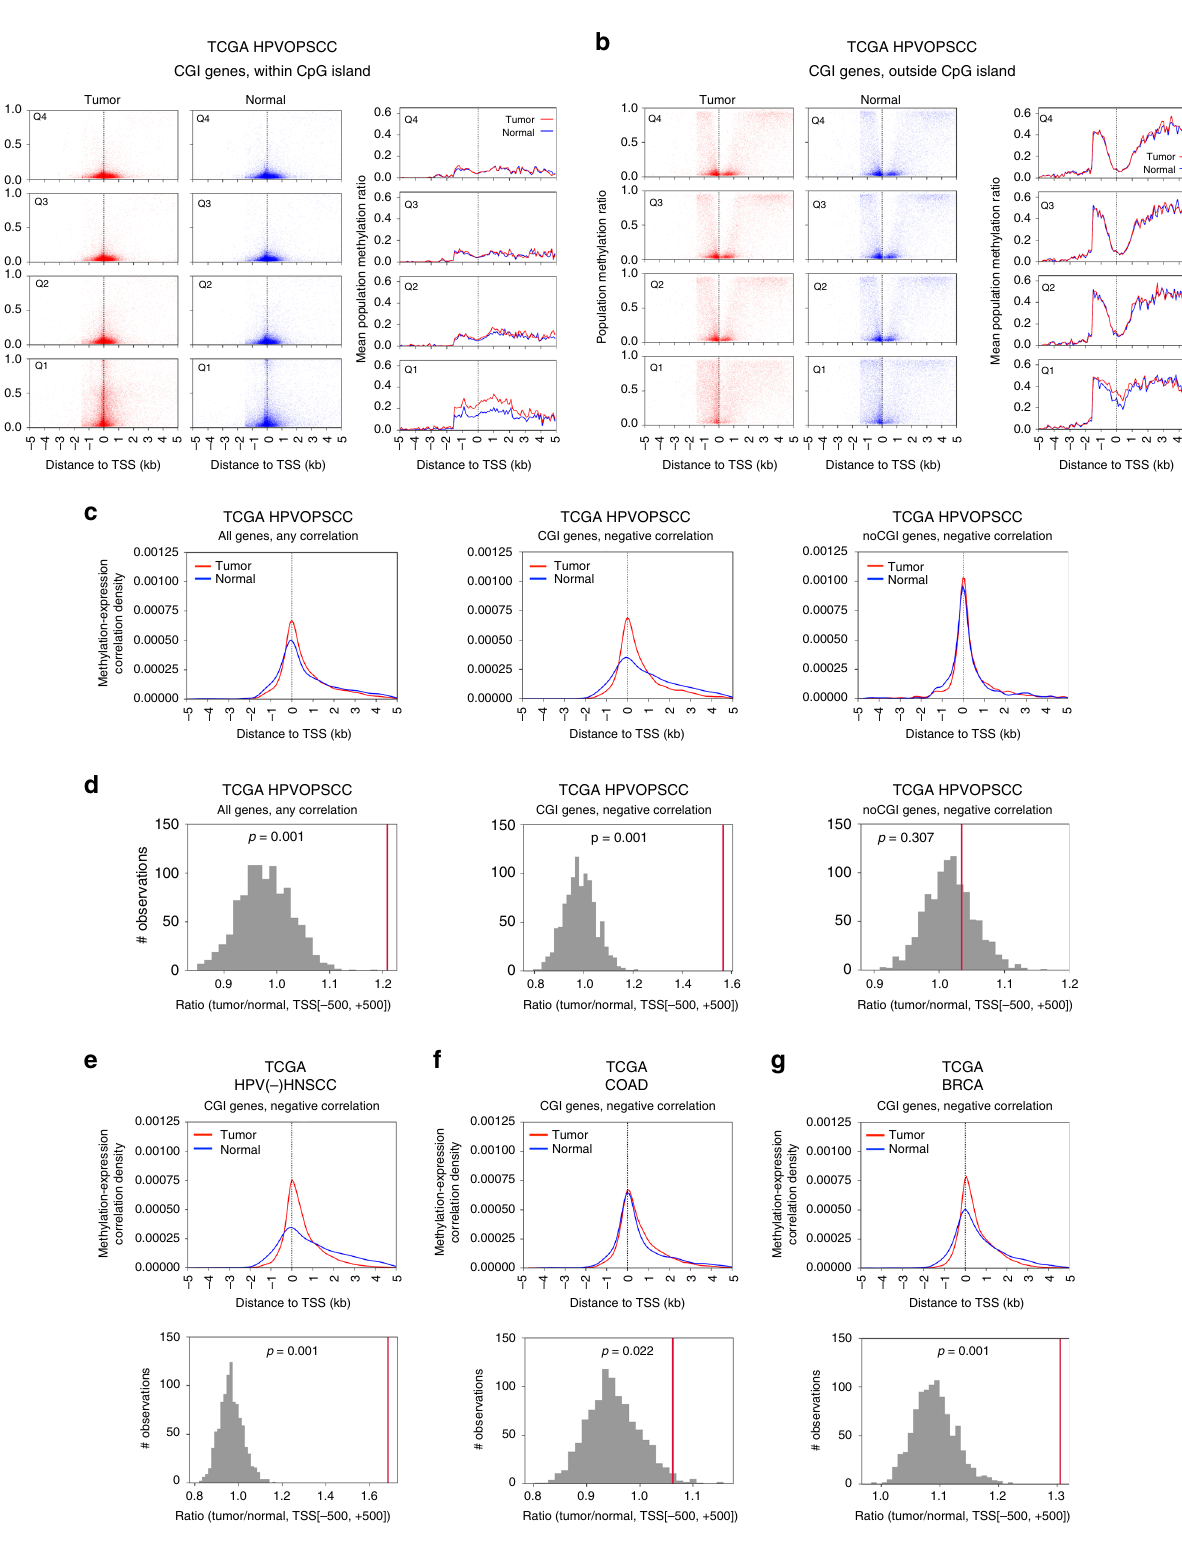
epithelial-to-mesenchymal transition 1,26,27 . A breast cancer